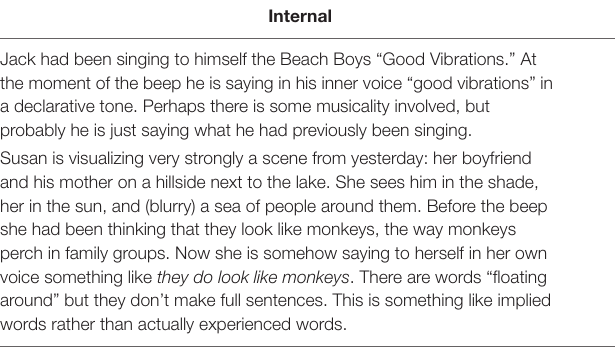
TABLE 1 | Examples of sampled experiences classified as internal, external, and social.